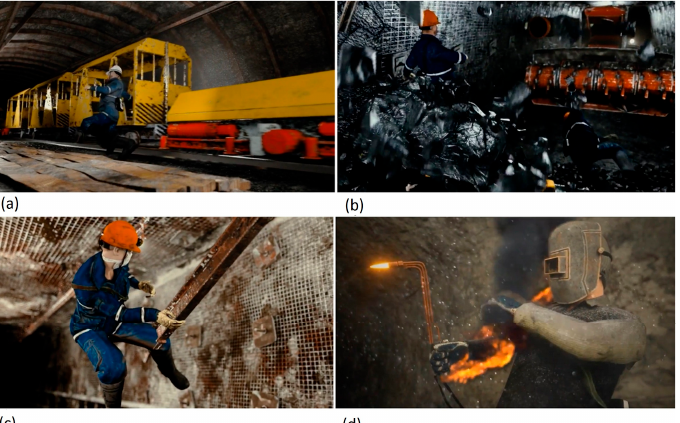
Figure 4. М odels of mine accidents modeled on game virtual 3D ProExpVR platform: ( a ) trolley hooking; ( b ) roof collapse; ( c ) fall from a height; ( d ) ignition during welding (Adapted from Refs. [45,46]).